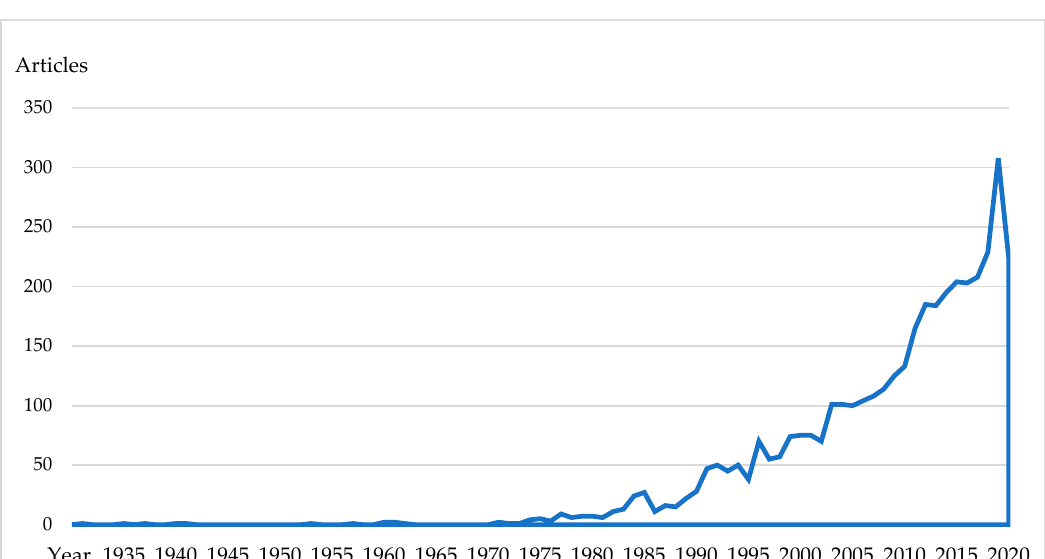
Figure 2. Number of articles published per year.